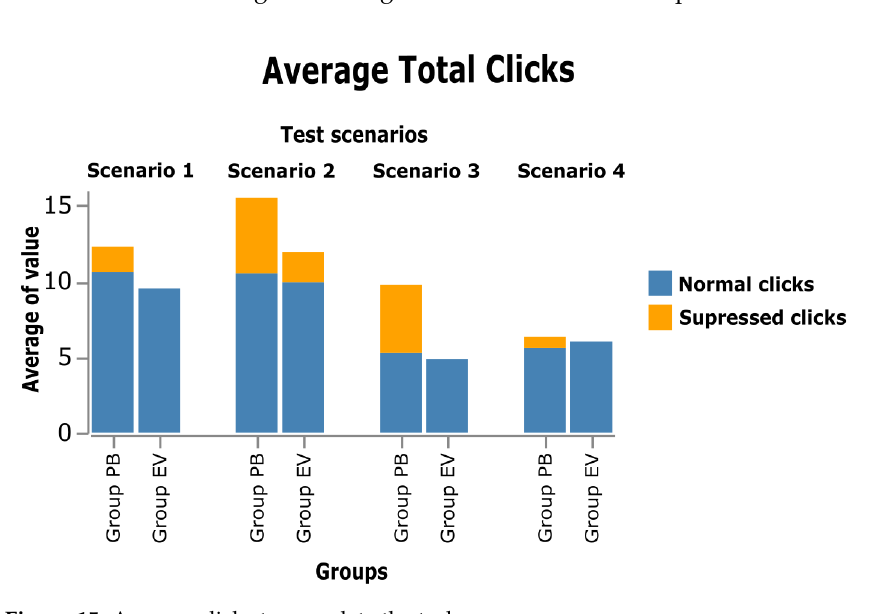
Figure 15. Average clicks to complete the